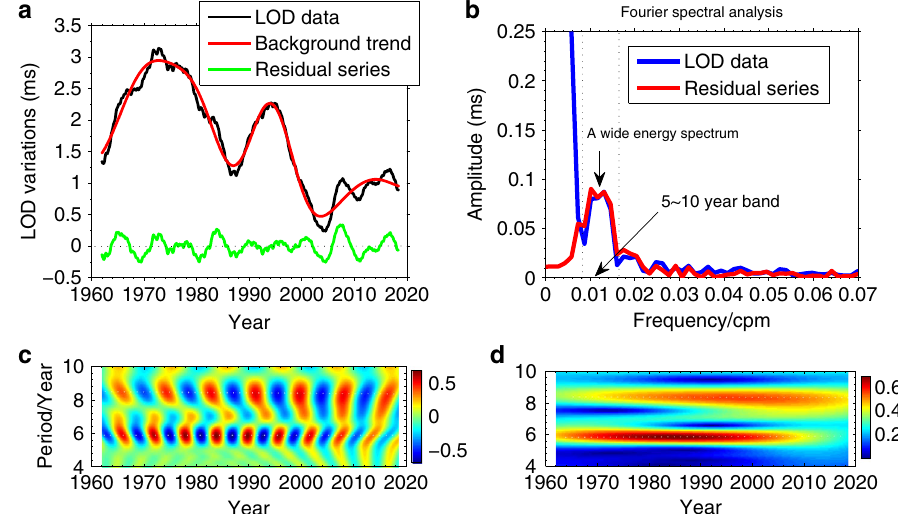
Fig. 1 The variations of length of day in time frequency domain. a Shows the LOD variations on the various scales, where the residual series (i.e., the green curve) mainly re fl ects the intradecadal variations, the frequency-domain result of which is shown in b ; b presents the Fourier spectrum of the LOD data and the intradecadal variations, which shows a wide energy-spectrum range in 5 – 10-year band instead of a single 6 years sharp peak; c , d show the NMWT time – frequency spectrum, which further reveals the periodic components existing on the 5 – 10-year scales. Here, the window width factor σ in NMWT method is set to be 3, which is large enough to clarify the target harmonic components, where the edge effect of the NMWT method and the strategy to eliminate it are illustrated in “ Methods ” section.